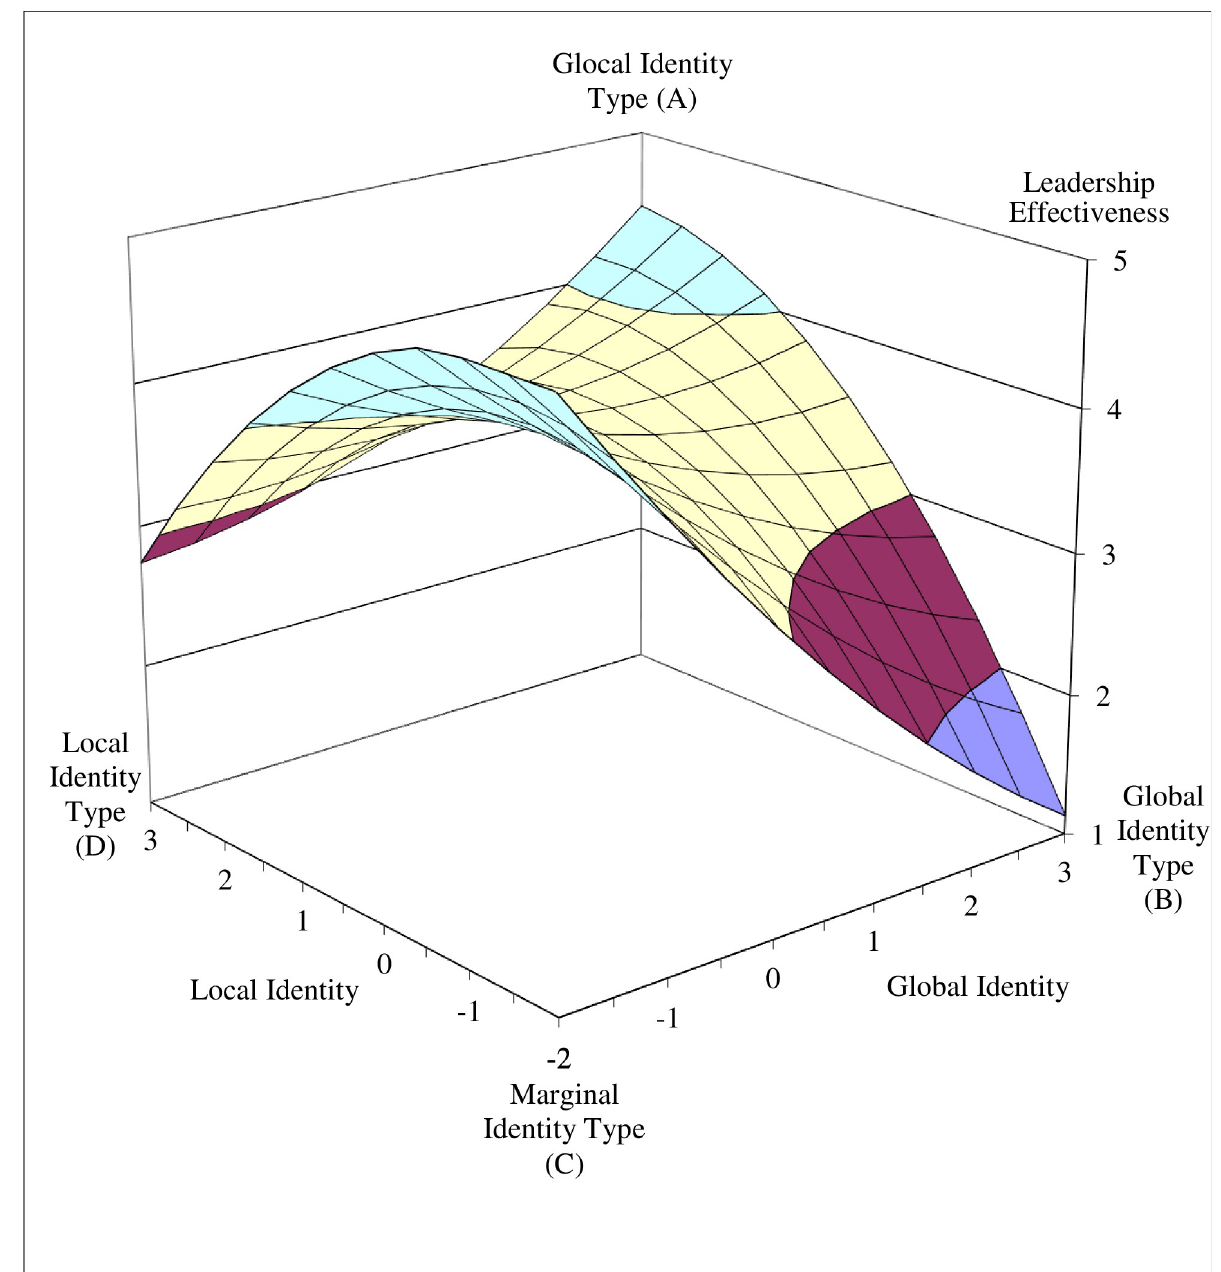
Fig 4. The four identity types as predictors of leadership